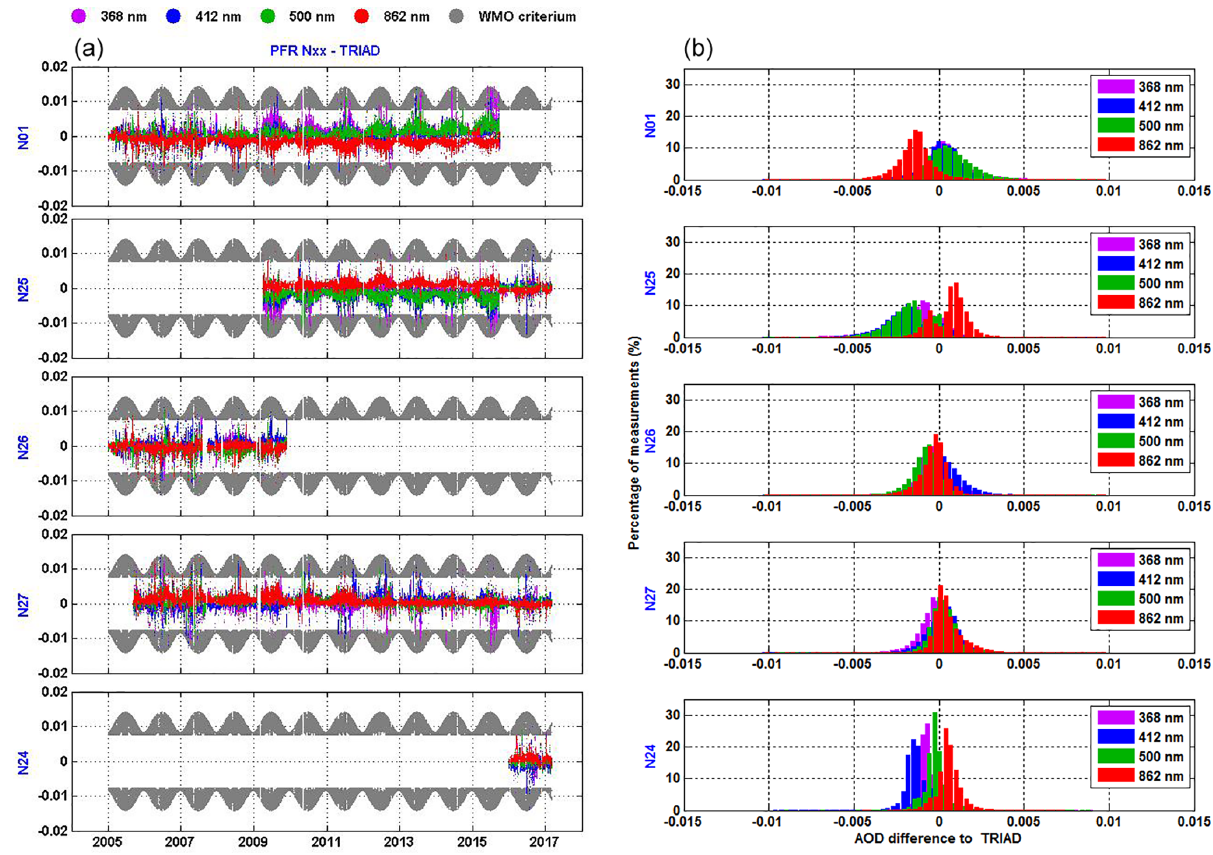
Figure 1. (a) Difference between each PFR with the mean of the PFR triad at the four PFR wavelengths. Grey areas represent the WMO-U95 limits. (b) Frequency distribution of these differences for the four measuring wavelengths.